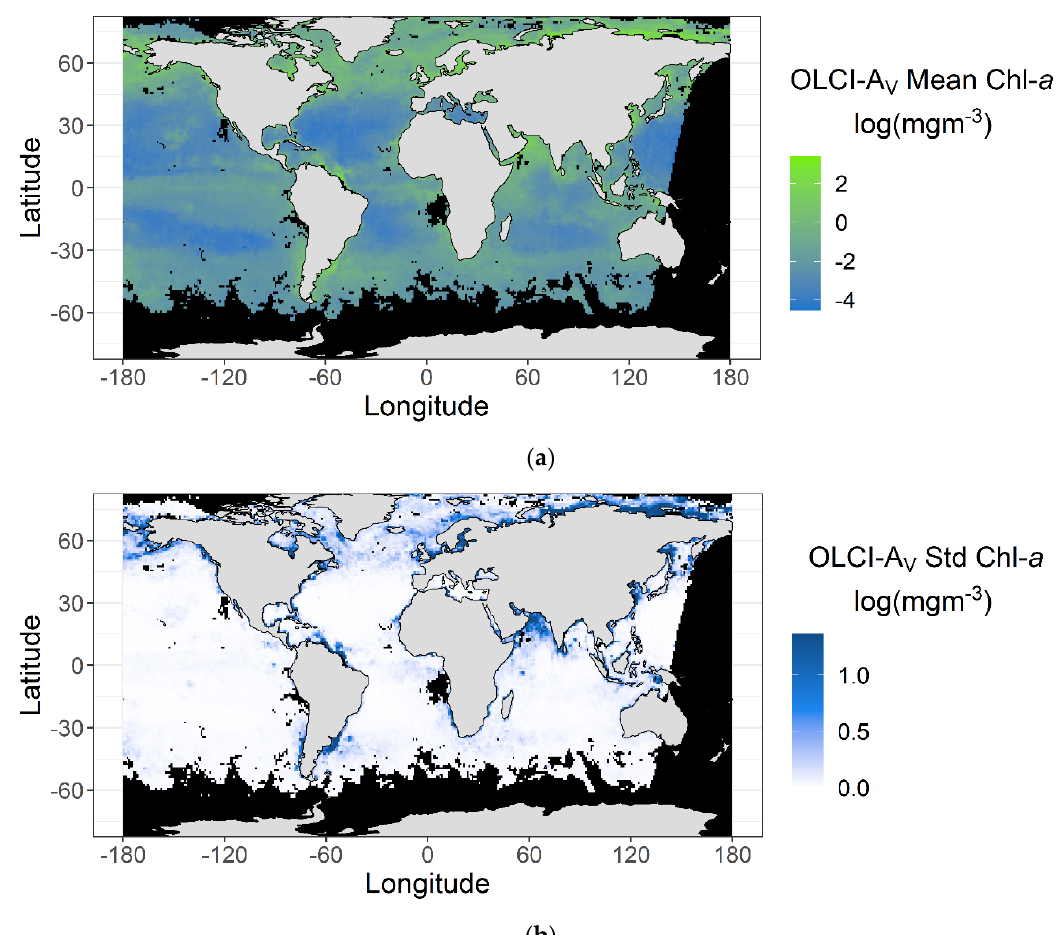
Figure A9. Global maps at 1 ◦ resolution of the OLCI-A-Vicarious chl- a ( a ) mean and ( b ) standard deviation over the tandem period. Black grid cells indicate missing data.